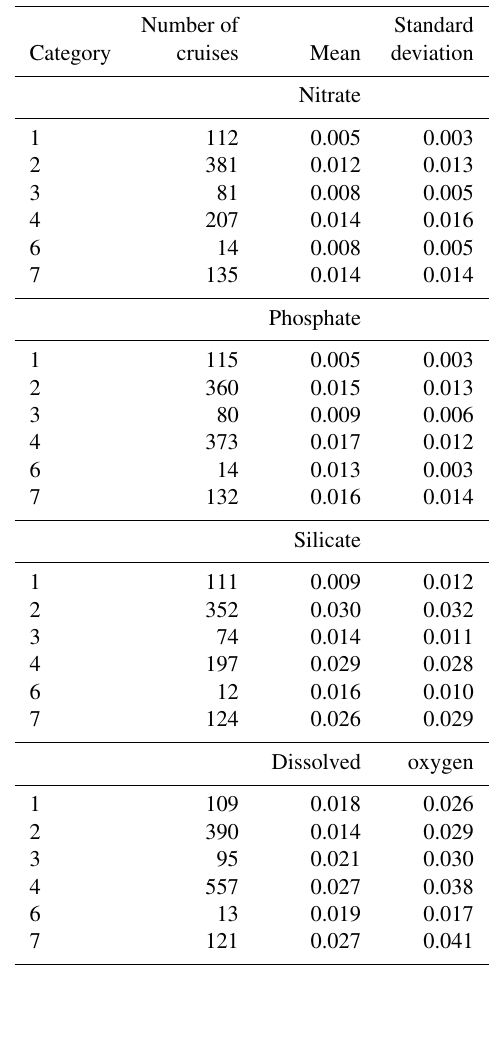
Table 2. Summary of means and standard deviations of the coef- ficient of variation (CV), a ratio of the standard deviations of the integrated values to a mean of the integrated value, within a 250km radius at crossovers for the four variables in each